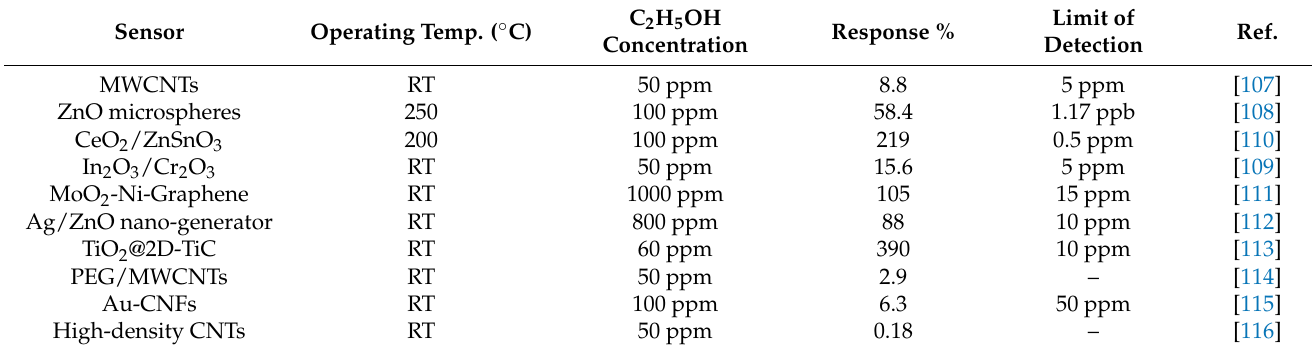
Table 5. The most recent chemiresistive C 2 H 5 OH sensors reported in the